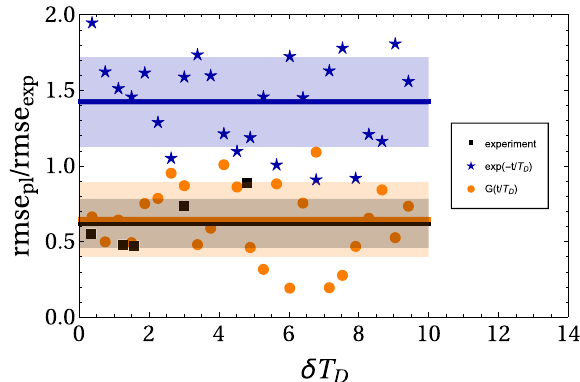
Fig. 4 Histograms of frequency estimators. The data is obtained from non-linear least squares fi tting of auto-correlations for experimental (upper row) and numerical (lower row) Qdyne time- traces. In blue, fi tting function assumes exponential decay of correlations while in orange the power-law model is considered. Each estimator corresponds to the highest R 2 in 500 fi ttings of the same time-trace. In ( a ), the phase φ is left as a free fi tting parameter while in ( b ) it is kept fi xed to φ = 0. ( c ) displays the results for numerical data generated for auto-correlations with power-law decay while in ( d ) the data is generated for exponentially decaying auto-correlations.